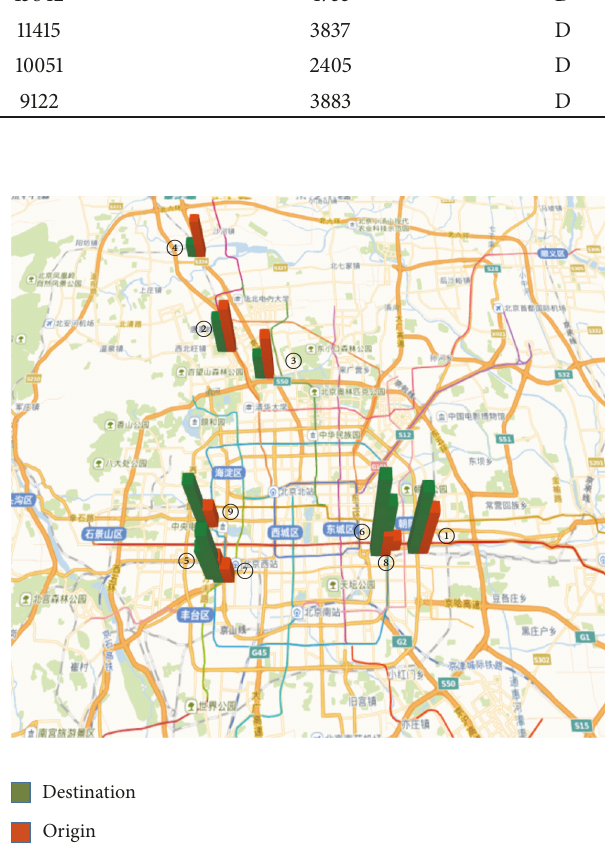
Figure 11: The top five origin stops and destination stops with the most passengers in the